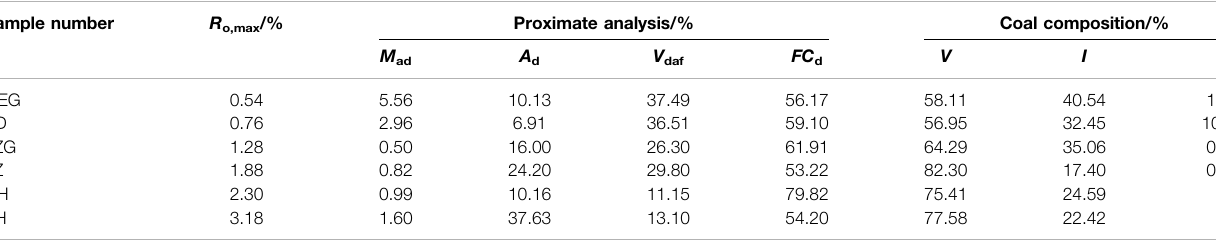
TABLE 1 | Vitrinite re fl ectance, industrial analysis, and macerals of samples. Sample